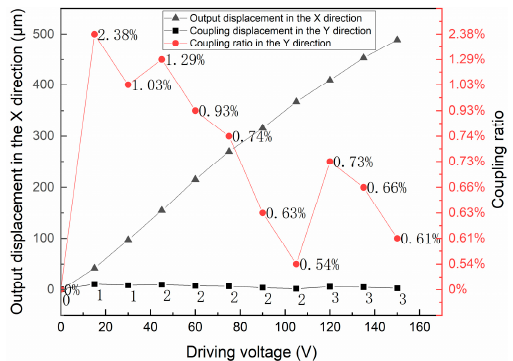
Figure 17. Y-direction coupling displacement when moving in the X direction of the platform.